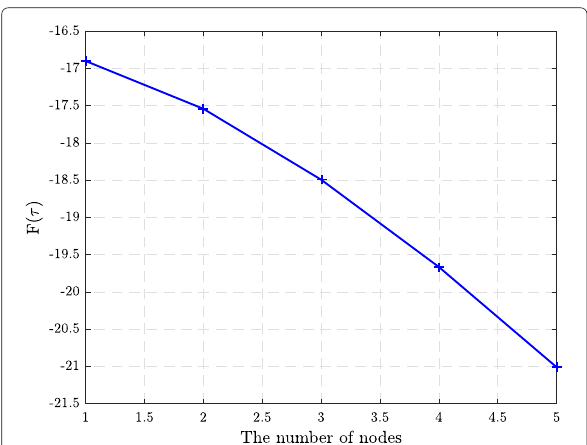
Fig. 4 F (τ i ) according to the number of nodes. Figure 4 shows that the objective function of (P2) is a concave function, to apply the convex optimization